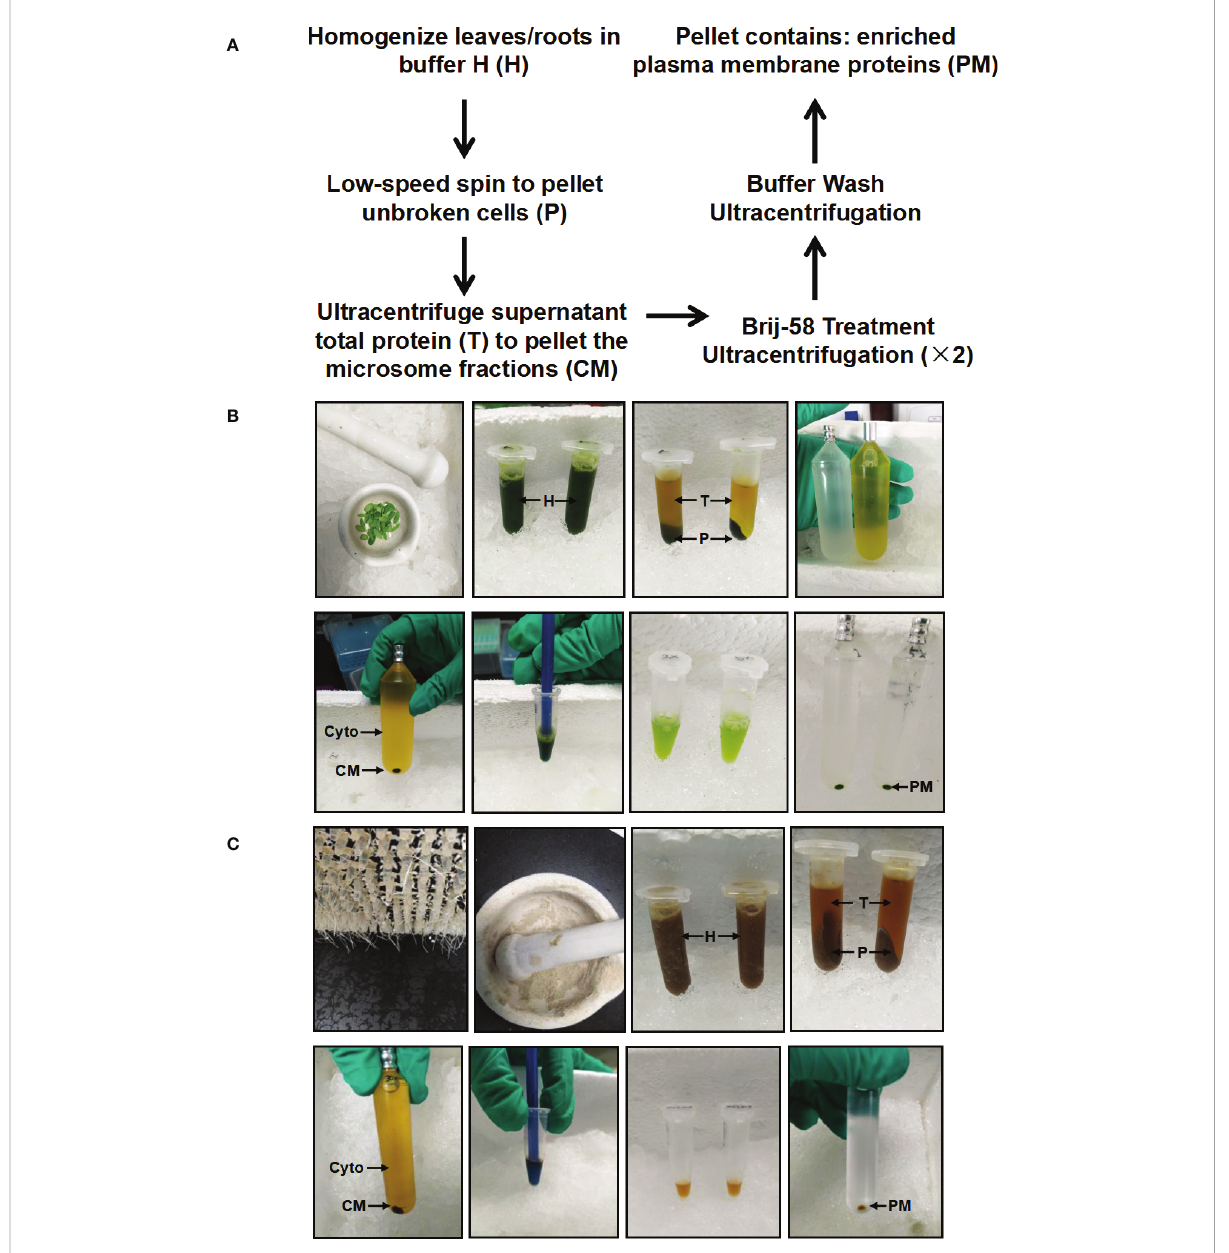
FIGURE 1 Schematic and image representation of the simpli fi ed plasma membrane enrichment procedure in leaf and root tissue of Stylosanthes . (A) Schematic representation of the procedure. (B) Images showing the key procedures in leaf tissue. (C) Images showing the key procedures in root tissue. After homogenization in Buffer H, the total homogenate (H) is subjected to low-speed spin to separate the supernatant (T: containing cytosolic and microsomal proteins) from the pellet (P: containing cell debris). The total protein fraction (T) is transferred to ultracentrifugation tube to pellet the crude microsome (CM) by ultracentrifugation, and the resulting supernatant contains cytosolic proteins (Cyto). The CM is resuspended in Buffer H with Brij-58, incubated on ice and subjected to ultracentrifugation to yield an enriched plasma membrane fraction